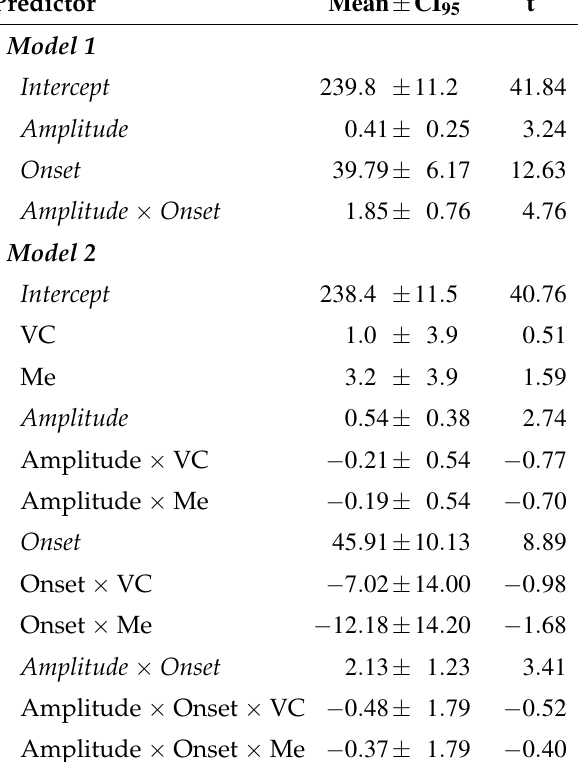
Means, 95% confidence intervals ( CI 95 , 1.96 times the stan- dard error), and t -values of fixed effects on SRTs after mi- crosaccades occurring after target onset, but no later than 70 ms after the go signal, estimated in two LME